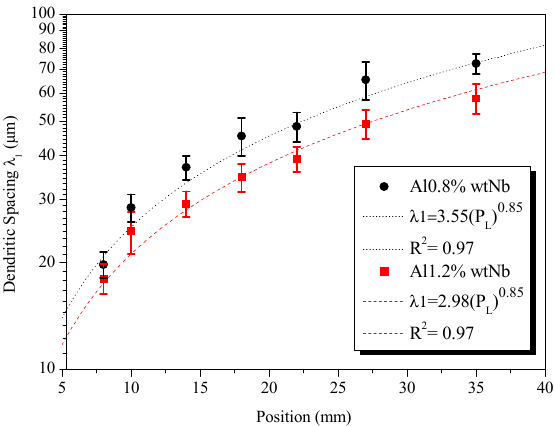
Figure 8. Experimental equations of the primary dendritic spacing as a function of the distance to the metal/mold interface, for alloys Al–0.8%wt Nb and Al–1.2 Nb.